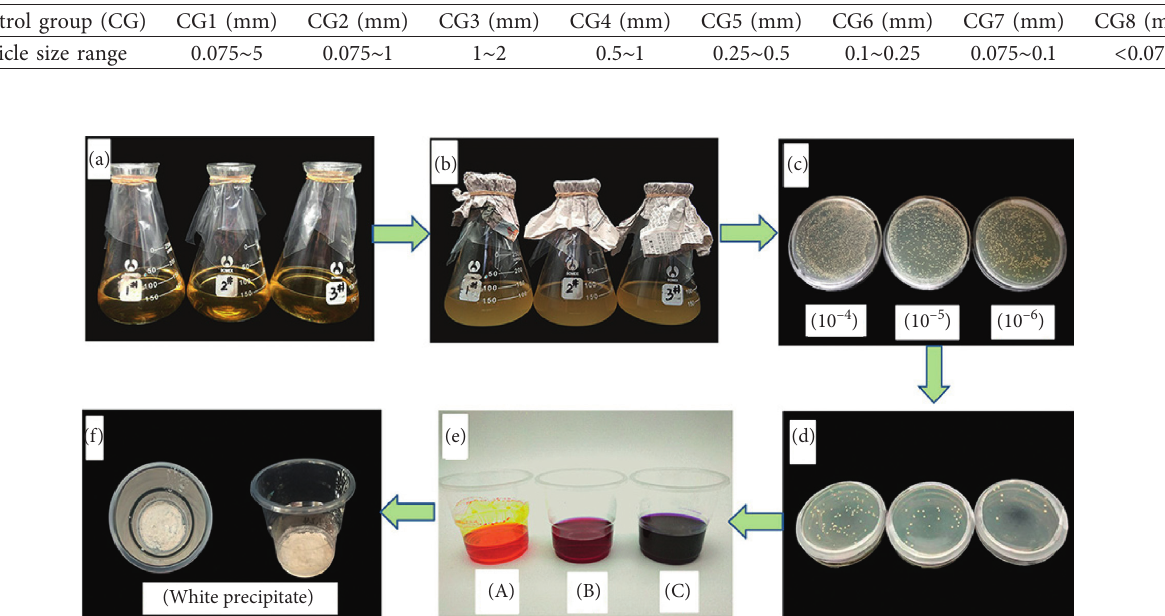
Figure 2: (a) Culture media. (b) Bacteria solution. (c) Separation strains. (d) Purified strains (single colony). (e) Change of culture media after adding acid-base indicator. (f) Verification of white precipitate.